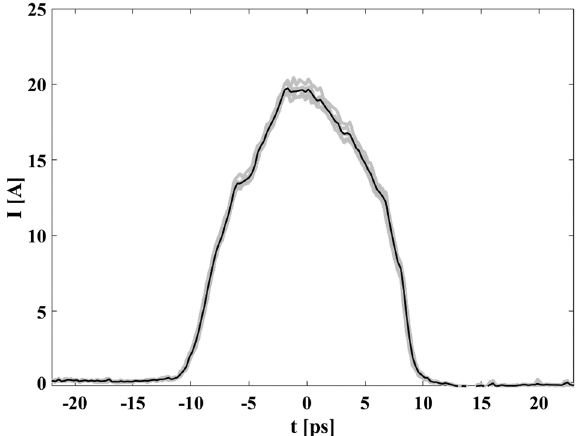
FIG. 9. Measured bunch length and shape by the exit of the injector. Shading curves represent 5 individual measurements and the black curve stands for the averaged